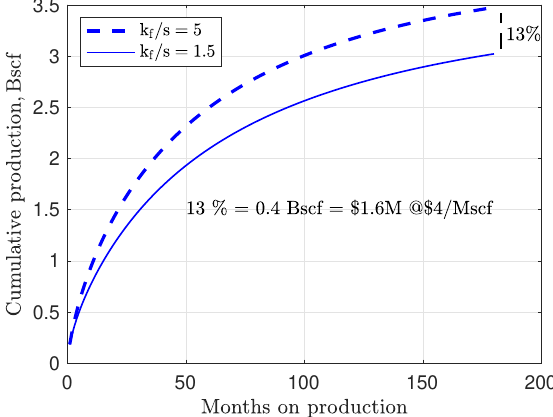
Figure 11. Cumulative production of two wells with the length of 640 m and the number of stages of 5. The k f / s ratio defines the fracture network efficiency of draining gas from the kerogen pore network. k f / s of 1.5 causes a faster pressure loss in the system, limiting cumulative production to 3 Bscf in 180 months. For the same well parameters (EPV width, number of stages, and hydrofracture height), k f / s of 5 or 6 gives 3.4 Bscf in 180